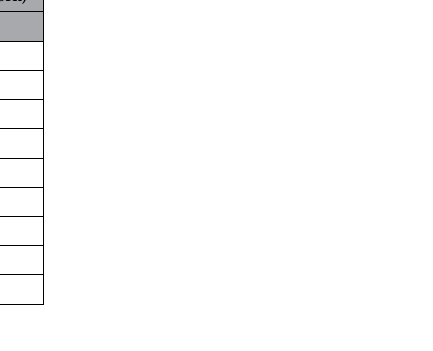
Table 2. Parameters of NbN and VN HEB